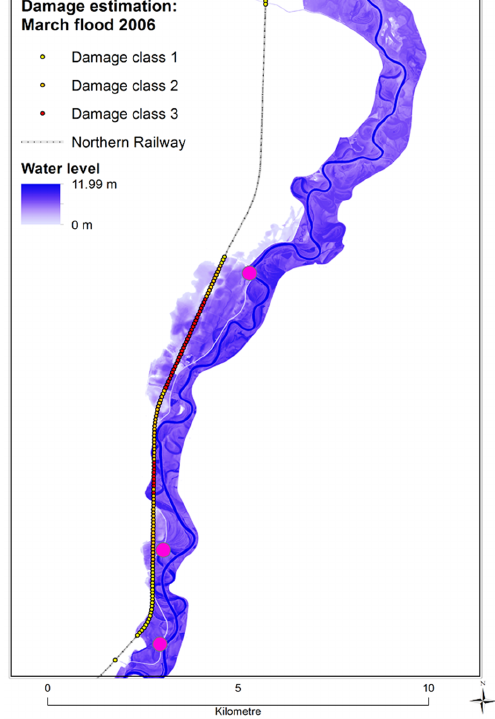
Figure 5. Estimation of damage potentials at the Northern Rail- way for the hydraulic conditions of the March River flood in 2006. During the event, three levee breaches occurred at three different locations along flood protection levee at the March River (see pink